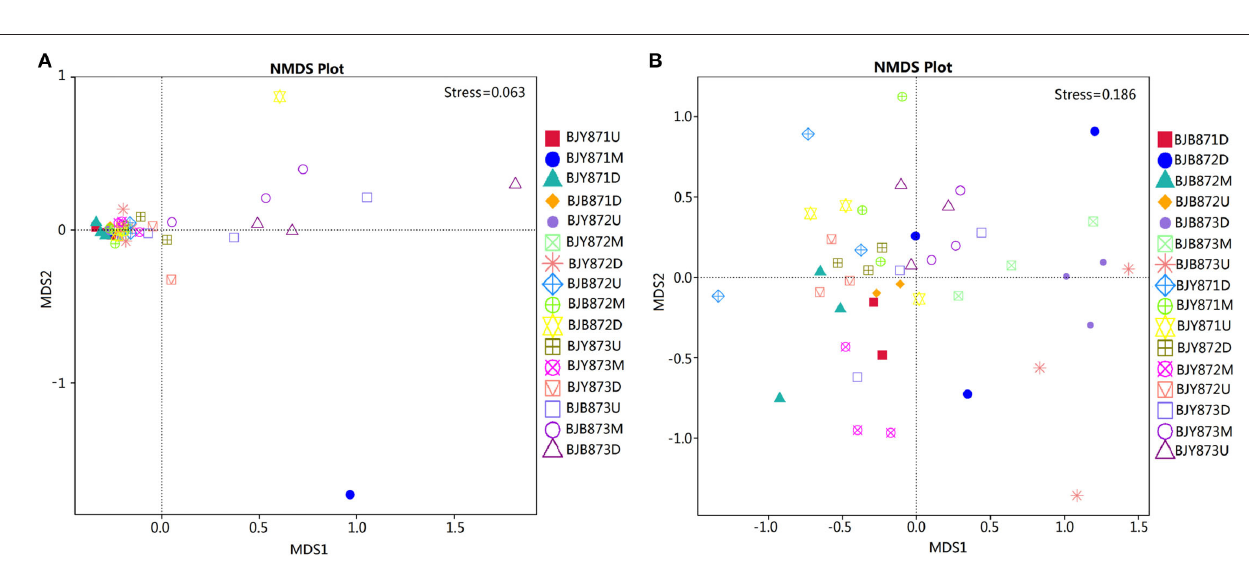
FIGURE 6 | Non-metric multi-dimensional scaling (NMDS) analysis of the fungal (A) and bacterial (B) communities. The spot represents one sample, the distance between two spots represents the degree of deviation, and the same color represents samples in one group. Stress value is < 0.2, indicating that NMDS could accurately reflect the difference of microbial communities among